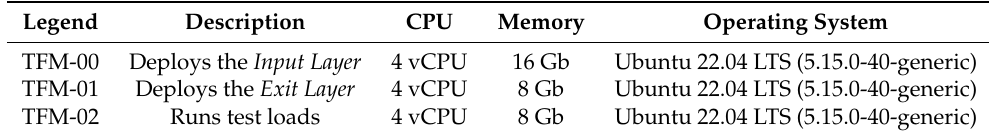
Table 1. Machines used for deployment and validation.